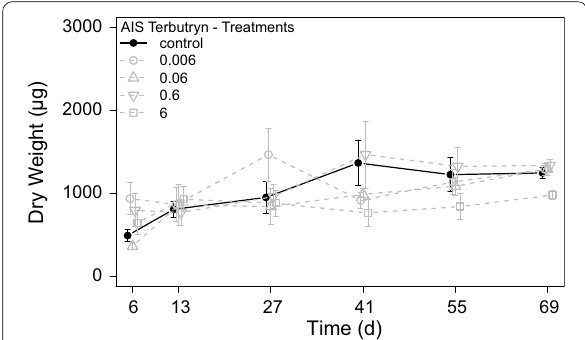
Fig. 4 Development of grazer dry weight during the exposure period of the terbutryn experiment in the different treatments [mean SE, n 6]. All terbutryn treatments in µg L − 1 ± =